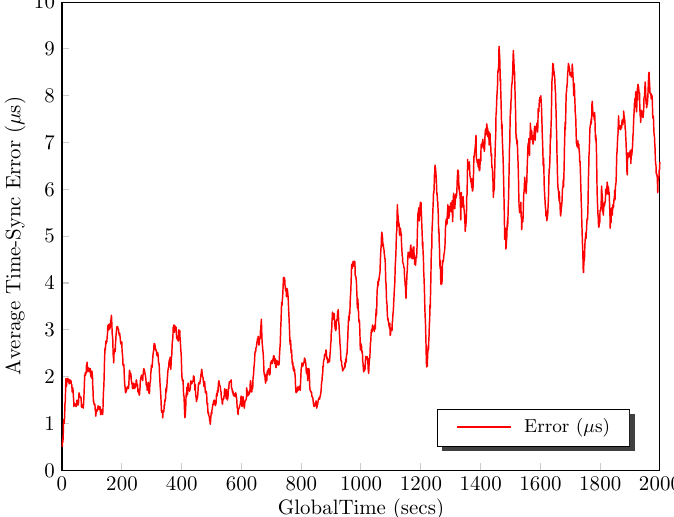
Figure 1. Temperature influence in Flooding Time Synchronization Protocol